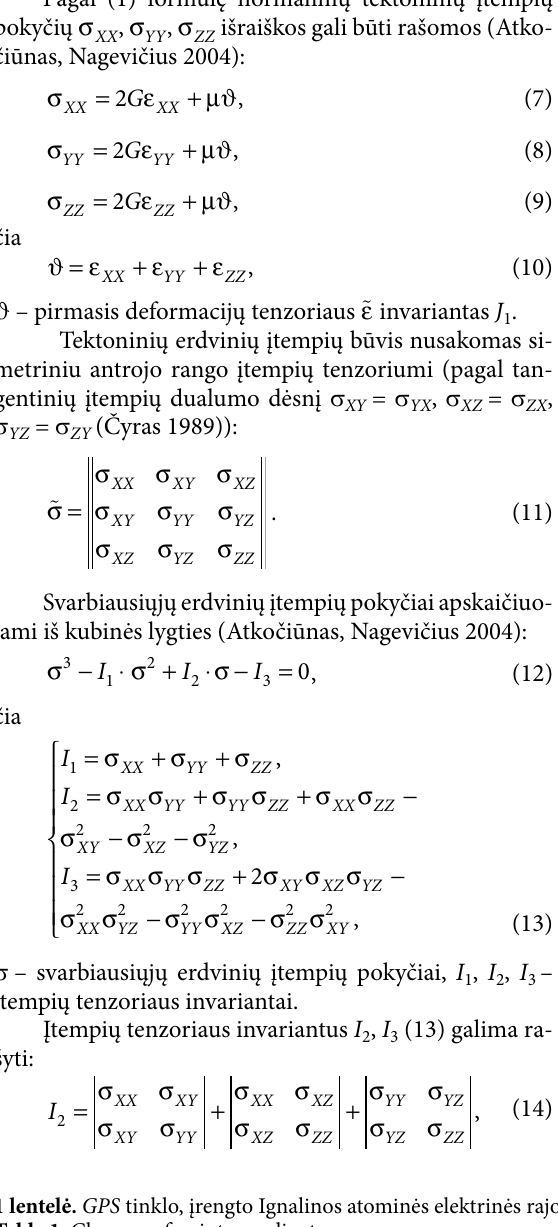
Table 1. Changes of point coordinates Punkto